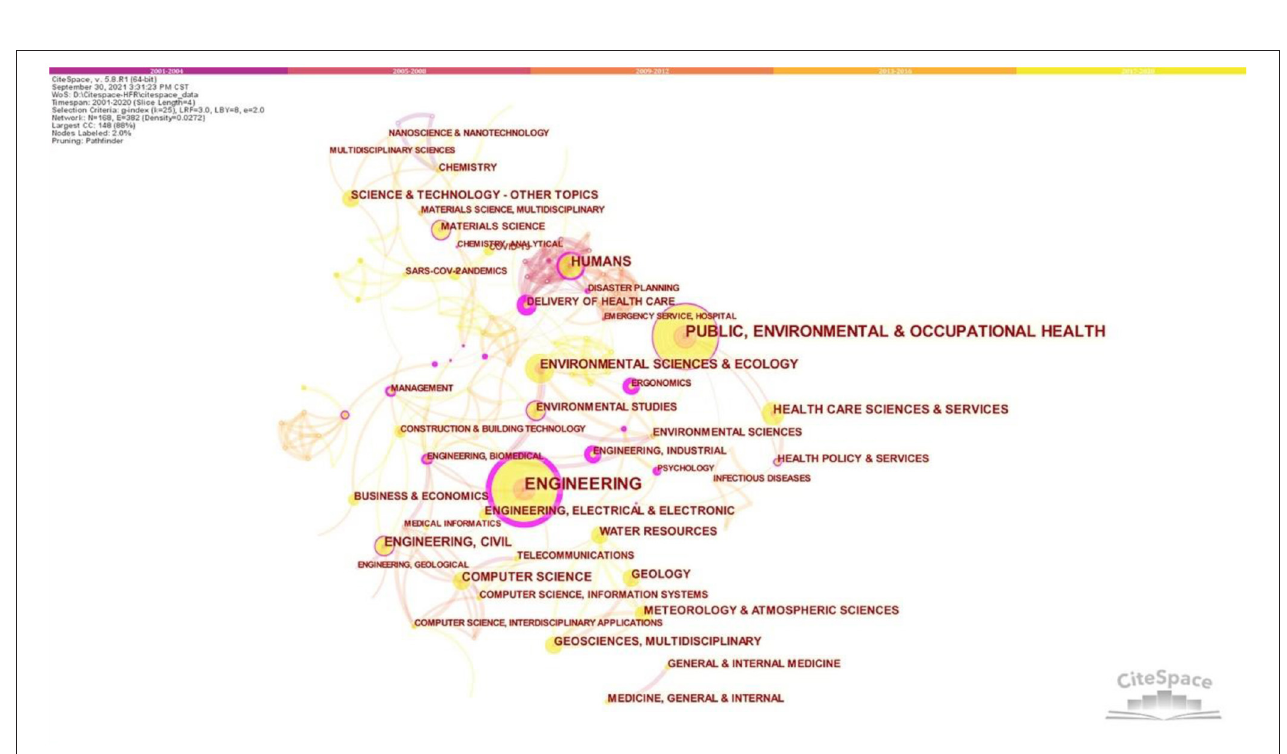
FIGURE 4 | Subject categories co-occurrence